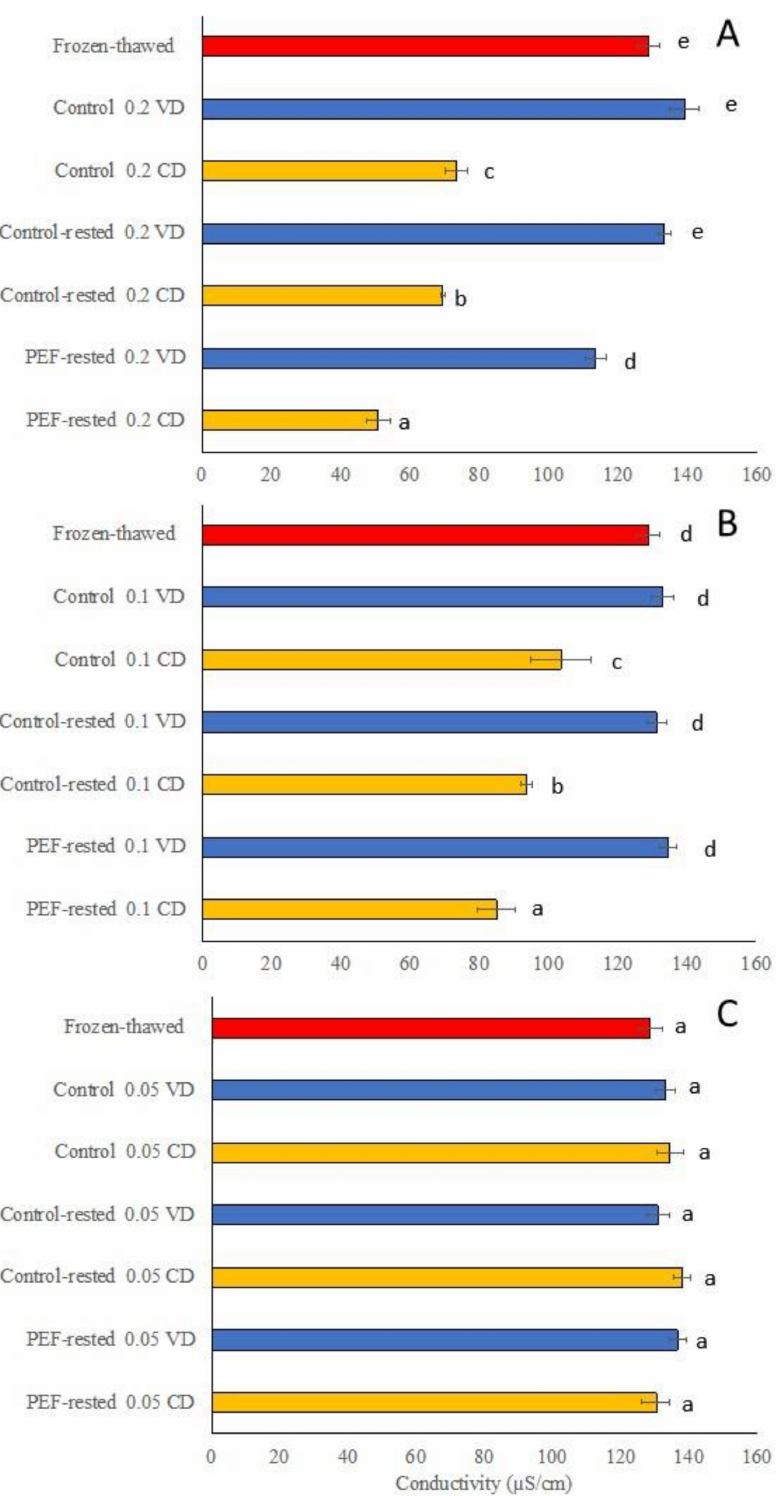
Figure 4. Electrical conductivity of rehydration water of dried Thai basil leaf samples subjected to different pretreatments (Control, Control-rested, and PEF-rested) and dried with two methods: convective drying (CD) and vacuum drying (VD) to the moisture ratio of 0.2 ( A ), 0.1 ( B ), and 0.05 ( C ). Reported are average and standard deviation of 21 measurements. Different letters next to the error bars indicate statistically significant differences ( p <